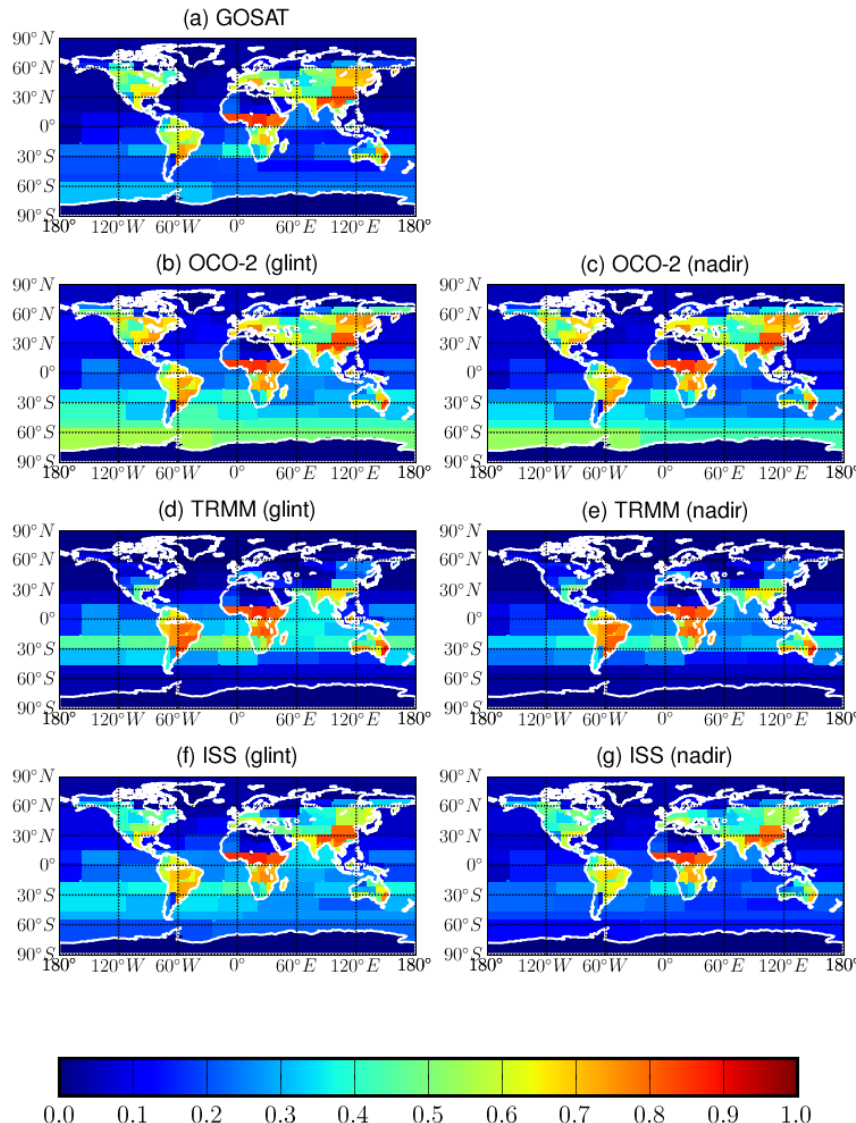
Fig. 4. The fractional error reduction γ of surface CO 2 fluxes for January 2003, averaged over 144 regions defined by the Transcom-3 regions (Feng et al., 2009), for GOSAT and OCO-2 in sun-synchronous orbits, and for an OCO-2 SWIR spectrometer in the NASA TRMM and ISS orbits. For GOSAT we consider the sum of nadir and glint measurements, reflecting its current operational mode. The error reduction is calculated as γ =1 − ˆ S i,i / S a , where ˆ S i,i and S a correspond to the i -th diagonal entry of the a posteriori and a priori error covariance matrices, respectively. For the purpose of this calculation we distinguish between OCO-2 nadir (left panels) and glint measurements (right panels).